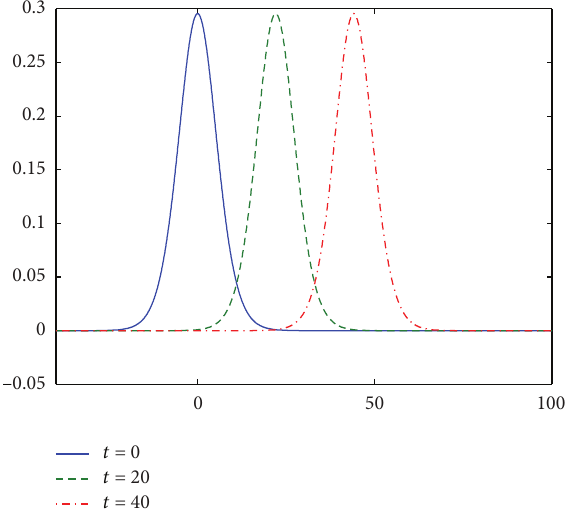
Figure 2: When 𝛼 = 1 and 𝜏 = ℎ = 0.05 , a numerical simulation figure on 𝑢(𝑥,𝑡) of Scheme II at various